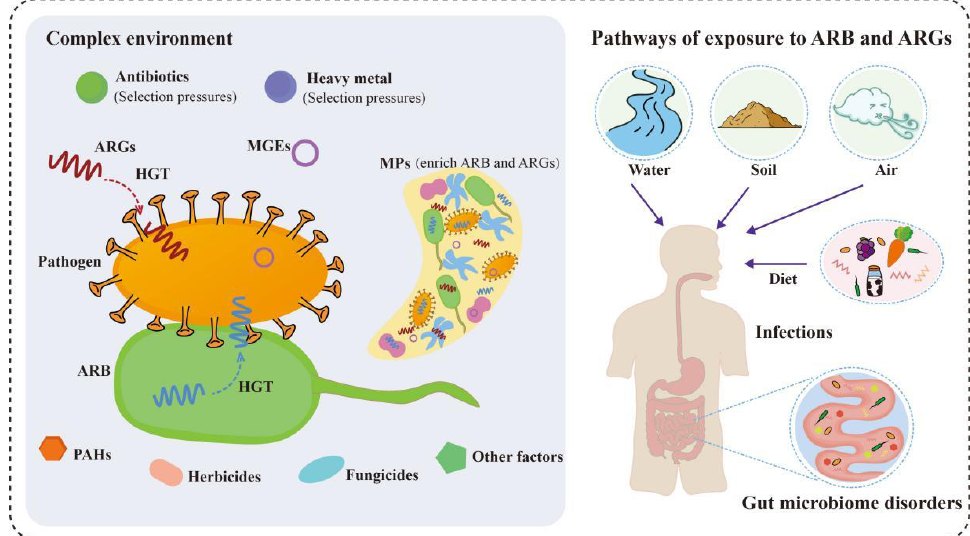
Figure 2. The impact of environmental pollutants on the spread of antimicrobial resistance and the pathways of human exposure to ARB and ARGs. Pollutants in complex environments promote the spread of ARGs, the reproduction of ARB, and the generation of the drug resistance of pathogens. The pathways of human exposure to ARB and ARGs in the environment mainly include skin contact, respiratory inhalation, and dietary intake, resulting in infections and gut microbiome disorders.